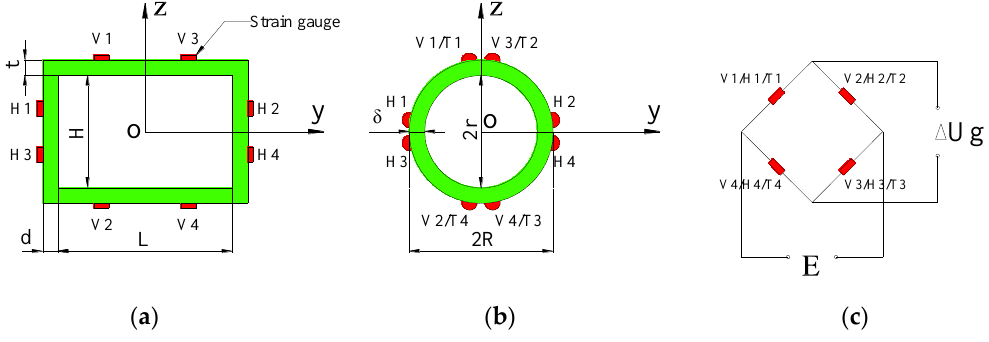
Figure 6. Stress measure scheme: ( a ) rectangular backbone for VBM and HBM; ( b ) circular backbone for VBM, HBM and TM; and ( c ) full-bridge circuit.